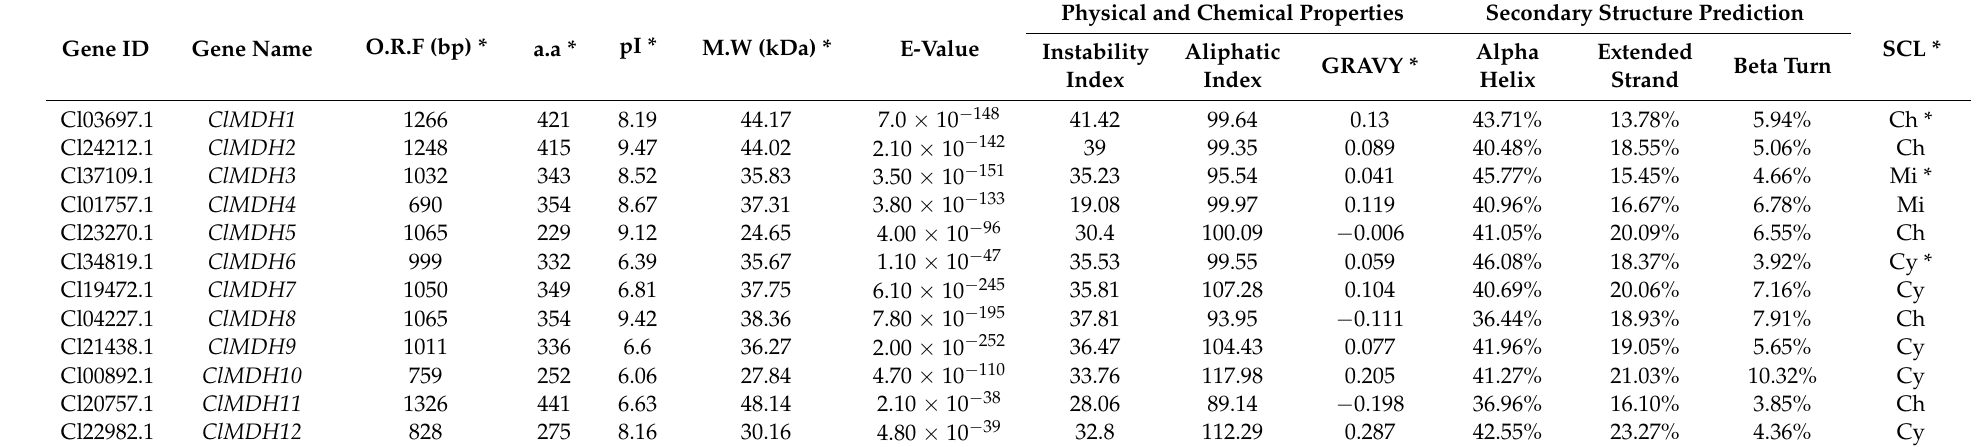
Table 1. ClMDH genes and predicted protein information in Chinese